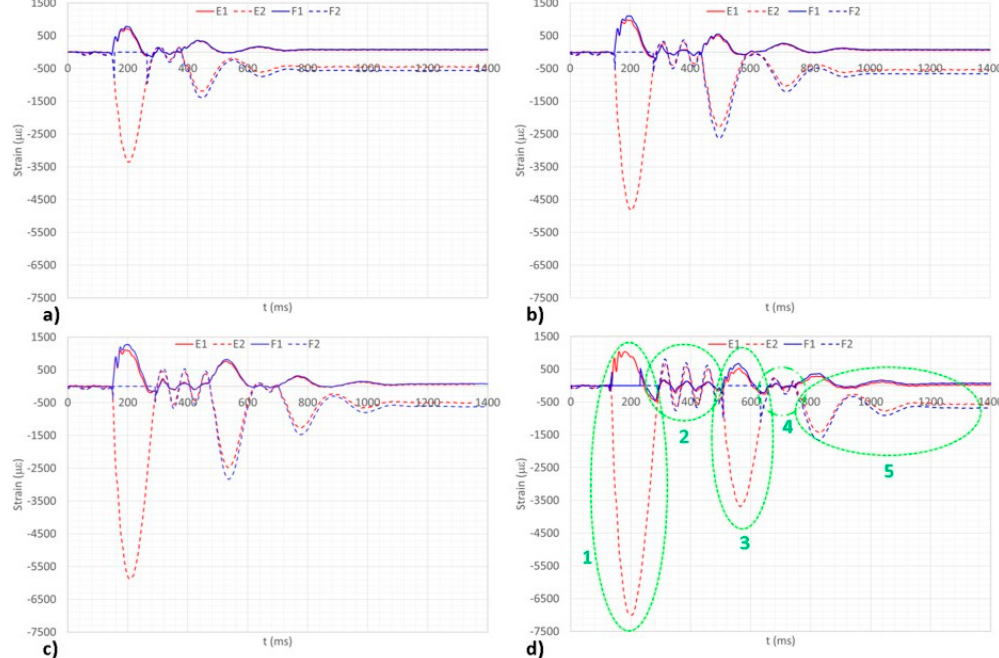
Figure 19. Right leg FBGs array signals recorded at four different heights. ( a ) h = 0.05 m; ( b ) h = 0.10 m; ( c ) h = 0.15 m; and ( d ) h = 0.20 m.